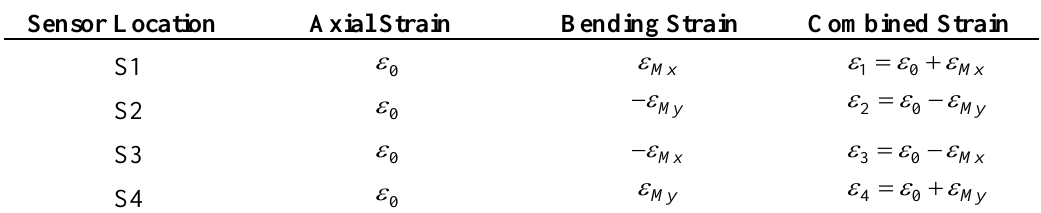
Table 1. Combined strain at each sensor